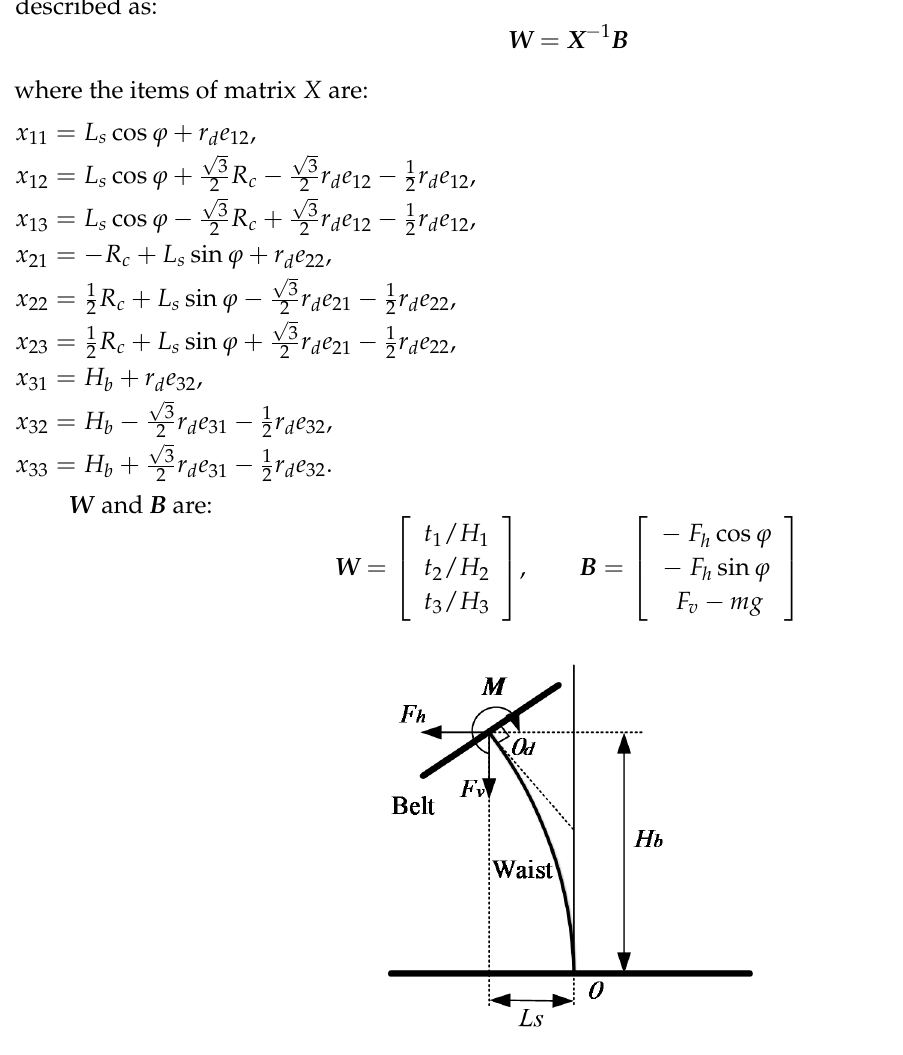
Figure 5. Force analysis of the waist.